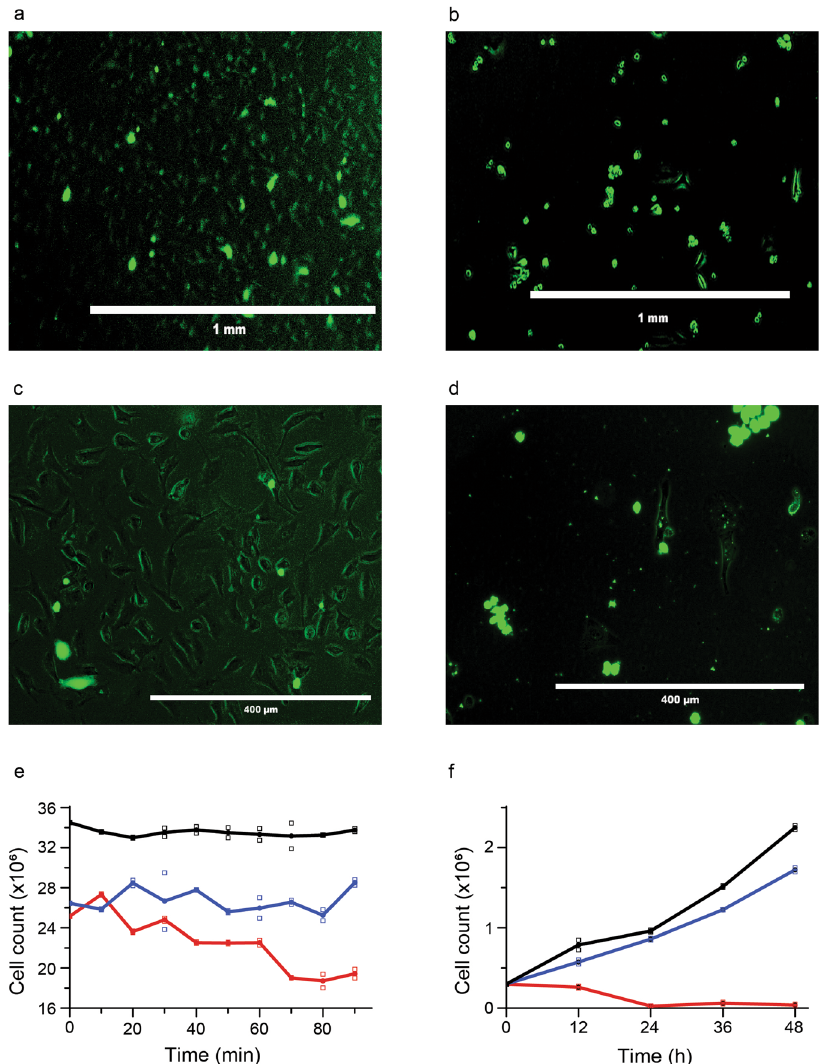
Fig. 2 VECT versus electroporation delivery of GFP to HeLa cells. a , c VECT delivery. b , d Electroporation delivery. e Short-term HeLa cell viability following transfection. f Long-term HeLa cell viability following transfection. Non-transfected (control) cells (black), cells with VECT-delivered protein (blue), and cells with electroporated-delivered protein (red). Data were reported as a mean based on two